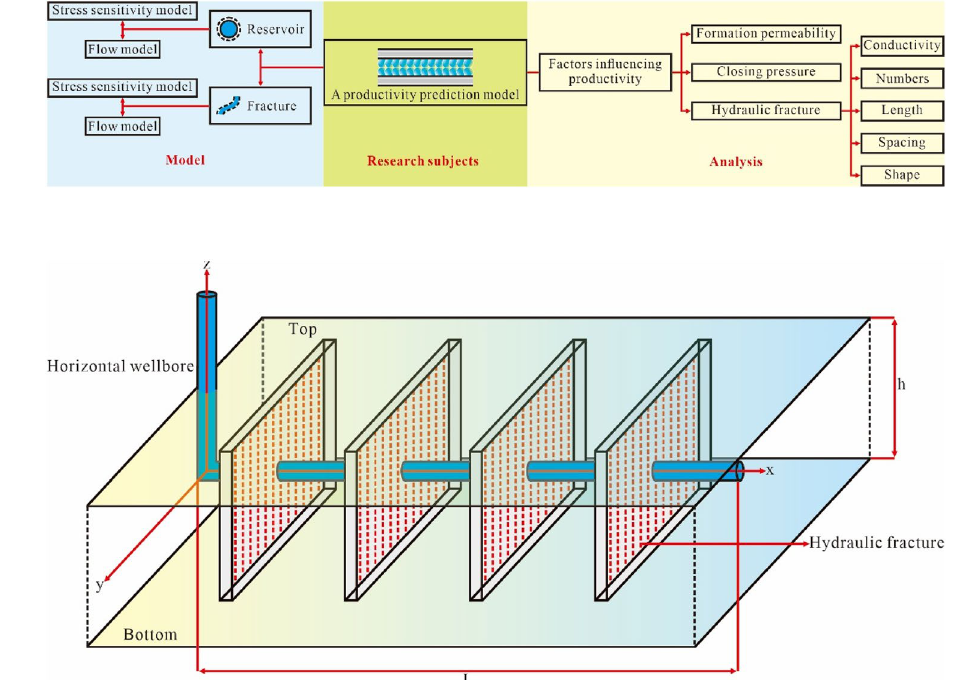
Fig. 1 Framework of the research topic